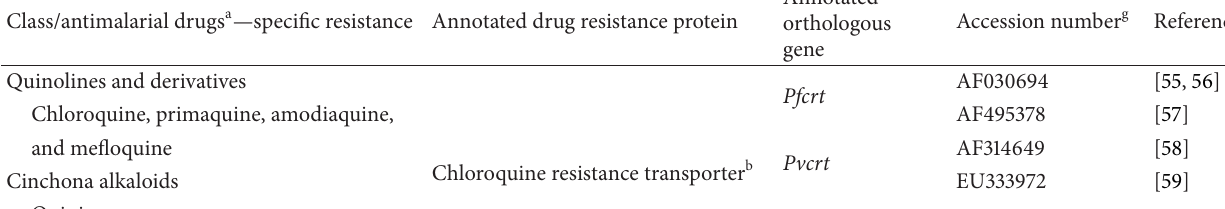
Table 1: Putative drug resistance genes as molecular markers for molecular xenomonitoring of MDR malaria parasites in Anopheles vectors. Class/antimalarial drugs a —specific resistance Annotated drug resistance protein